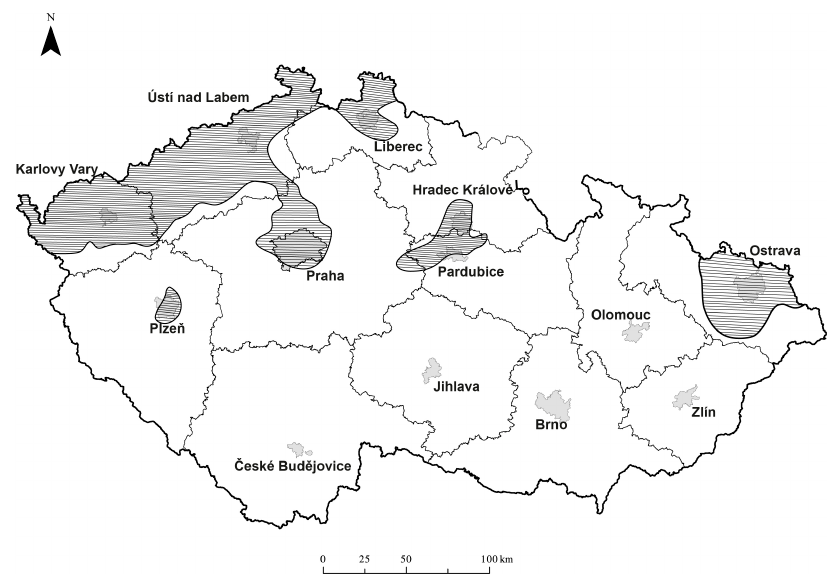
Figure 5. Map indicating the formerly impacted regions (in the 1970s and 1980s) with respect to air pollution delimited by annual SO 2 mean concentration above 30 µg m − 3 (redrawn according to [41]).